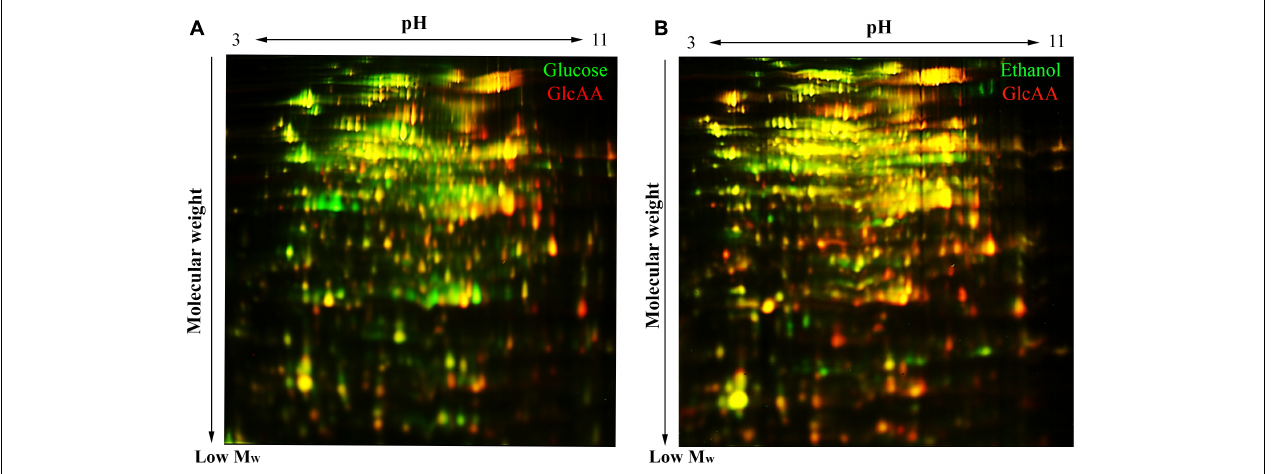
FIGURE 5 | 2D-DiGE gel images illustrating the difference of proteome composition of A. senegalensis LMG 23690 T acclimated to different carbon sources. (A) Comparison of cells acclimated to glucose (green spots) and cells acclimated to a mixture of glucose and acetic acid (red spots). (B) Comparison between the cells acclimated to EtOH condition (green spots) and the cells acclimated to a mixture of glucose and acetic acid (red spots). The yellow spots indicate the overlapping proteins (red and green spots) with similar abundance in both conditions.